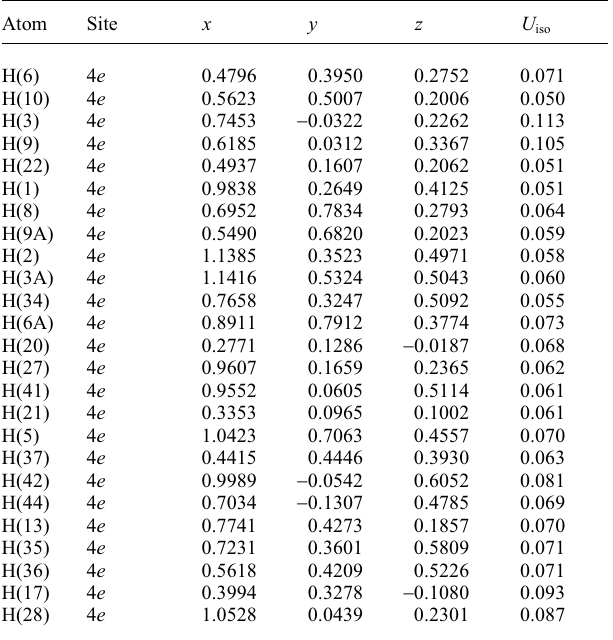
Table 2. Atomic coordinates and displacement parameters (in Å 2 )